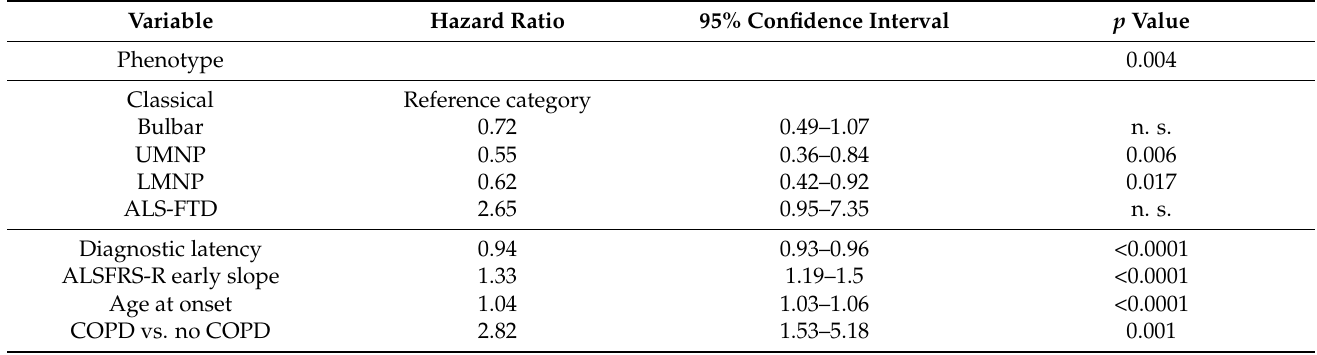
Table 5. Probability of survival (multivariable Cox regression model with forward